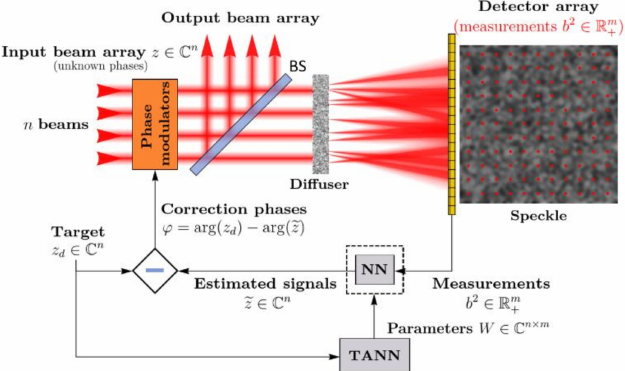
Figure 2. Feedback loop with target adaptive neural network TANN that computes the weights of the NN embedded in the loop, at each change of the